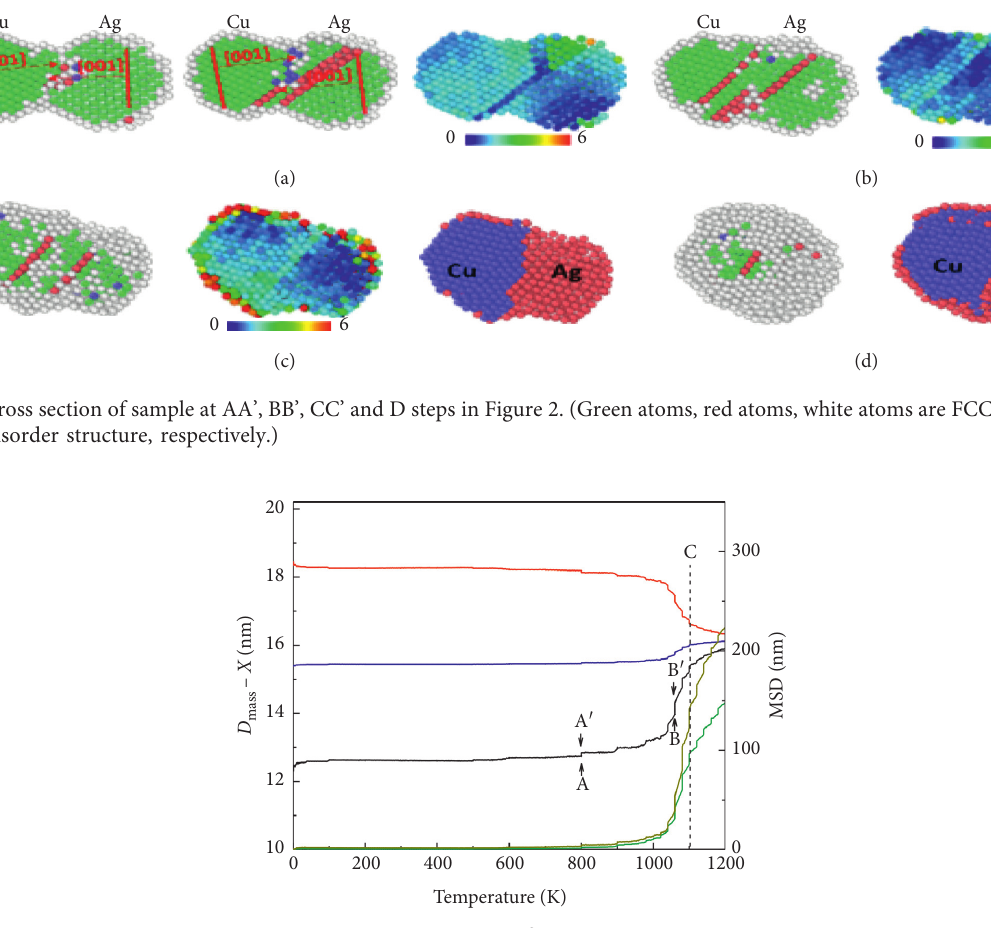
− X and MSD of CuAg-6nm. mass